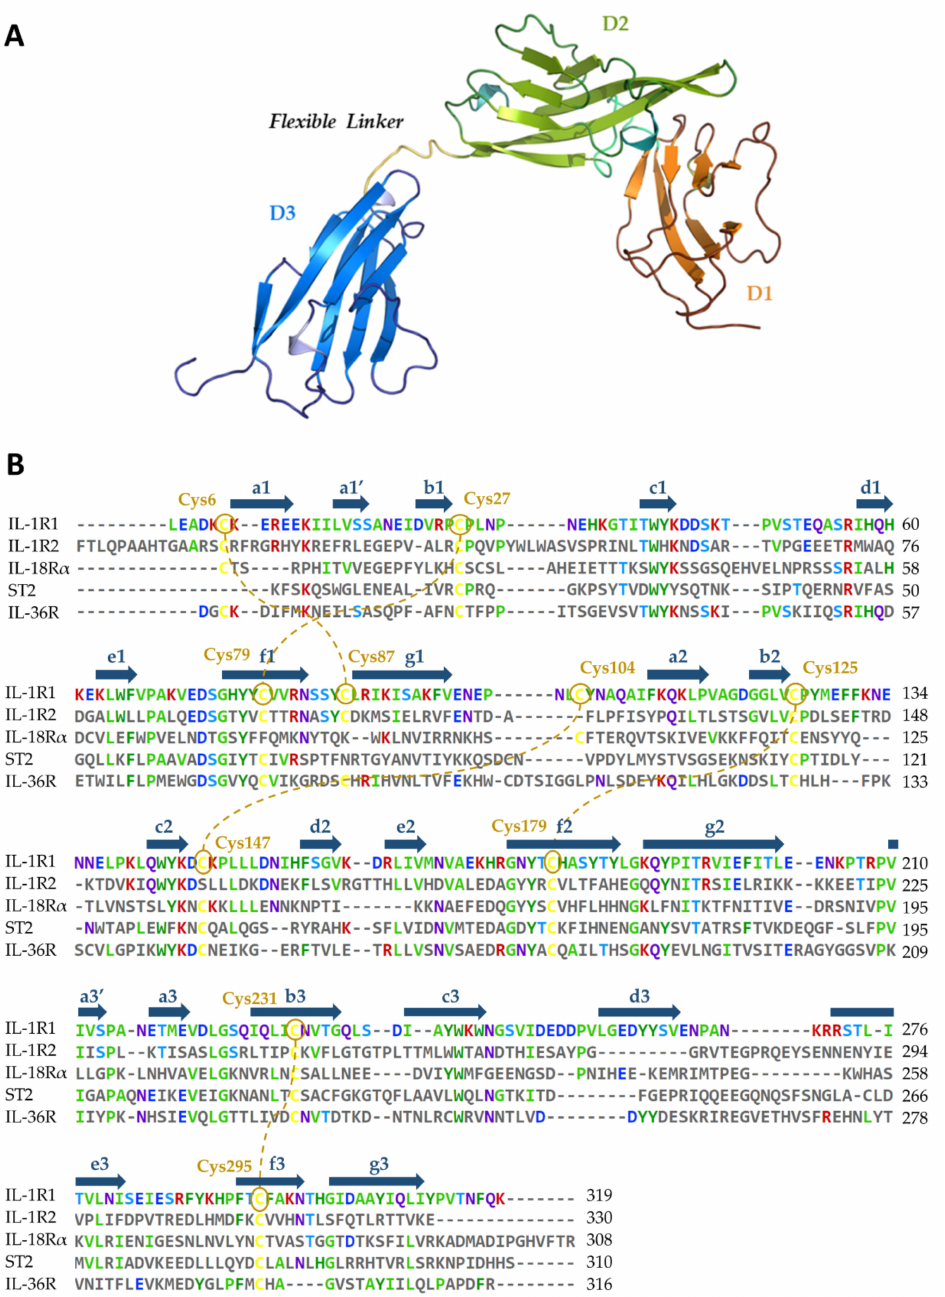
Figure 4. ( A ) Molecular structure the IL-1R1 ectodomain. The coordinates were retrieved from the PDB (PDB entry 4GAF). The Ig-like domains are labeled as D1 (orange), D2 (green) and D3 (blue), and the 6 amino acid flexible linker located between D2 and D3 is represented in yellow. ( B ) Alignment of IL-1R1, IL-1R2, IL-18R α , ST2 and IL-36R ectodomains. The β -strands were assigned using the DSSP algorithm [191], and are shown for the IL-1R1 sequence (a1-g1 located in D1, a2-g2 located in D2 and a3-g3 located in D3, represented as blue arrows). Brown circles show the conserved cysteine residues, and the connectivity between the disulfide bonds in the IL-1R1 structure is represented by brown dashed lines. IL-1R1 shares 25.5%, 18.4%, 19.6% and 29.3% sequence identity with IL-1R2, IL-18R α , ST2 and IL-36R, respectively. The alignments were generated using the Clustal Omega Server [192]. Adapted from [193]. Figure abbreviations: IL-1R1, interleukin-1 receptor type 1; IL-1R2, interleukin-1 receptor type 2; IL-18R α , interleukin-18 receptor- α ; ST2, defined as interleukin-33 receptor; IL-36R, interleukin-36